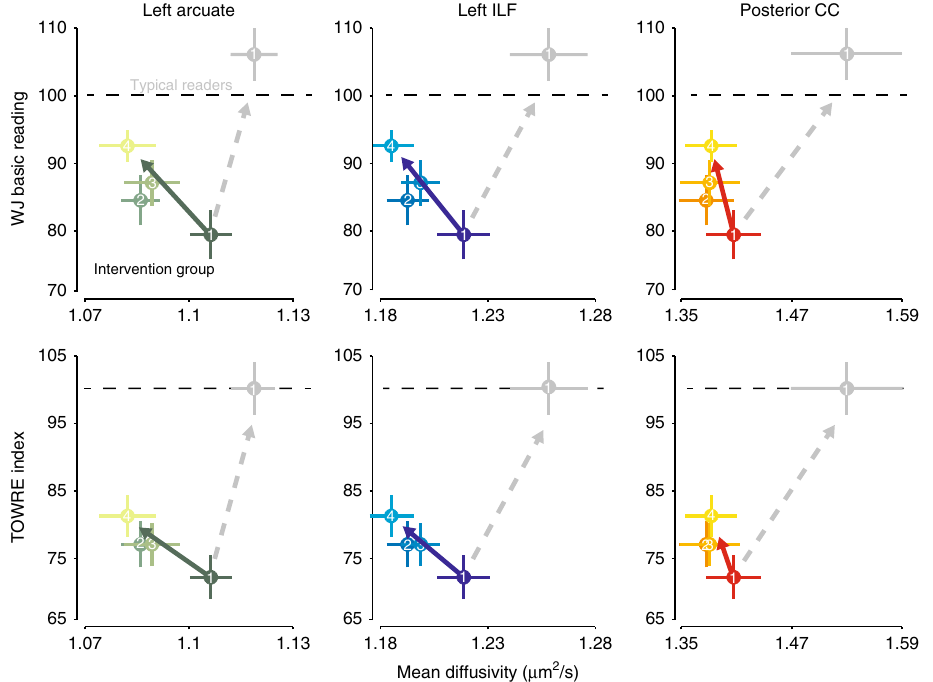
Fig. 3 Reading intervention does not normalize differences in the white matter. Reading skill is plotted as a function of mean diffusivity for each session (1 – 4) for the left arcuate, ILF, and posterior callosal tracts in the intervention group. The gray circle and lines in each panel show the mean and standard error at Session 1 for the subset non-intervention control subjects with reading skills in the typical range (poor reading controls were excluded, leaving n = 10 typical reading controls). The dashed gray arrow shows the expected trajectory for MD values if the intervention group were to become more similar to the typical reading controls in terms of both reading skills and MD. In contrast, the true trajectory of change in plotted as a colored arrow in each panel. The intervention group includes some readers with only moderate reading impairments (and, therefore, higher MD values), and so the group difference in pre- intervention scores is less than would be expected for a group of good vs. poor readers. Supplementary Fig. 7 reproduces the intervention data alongside the same mean and SE plots for the full sample of control subjects during sessions 1 – 3, to further illustrate the relative stability of both white matter